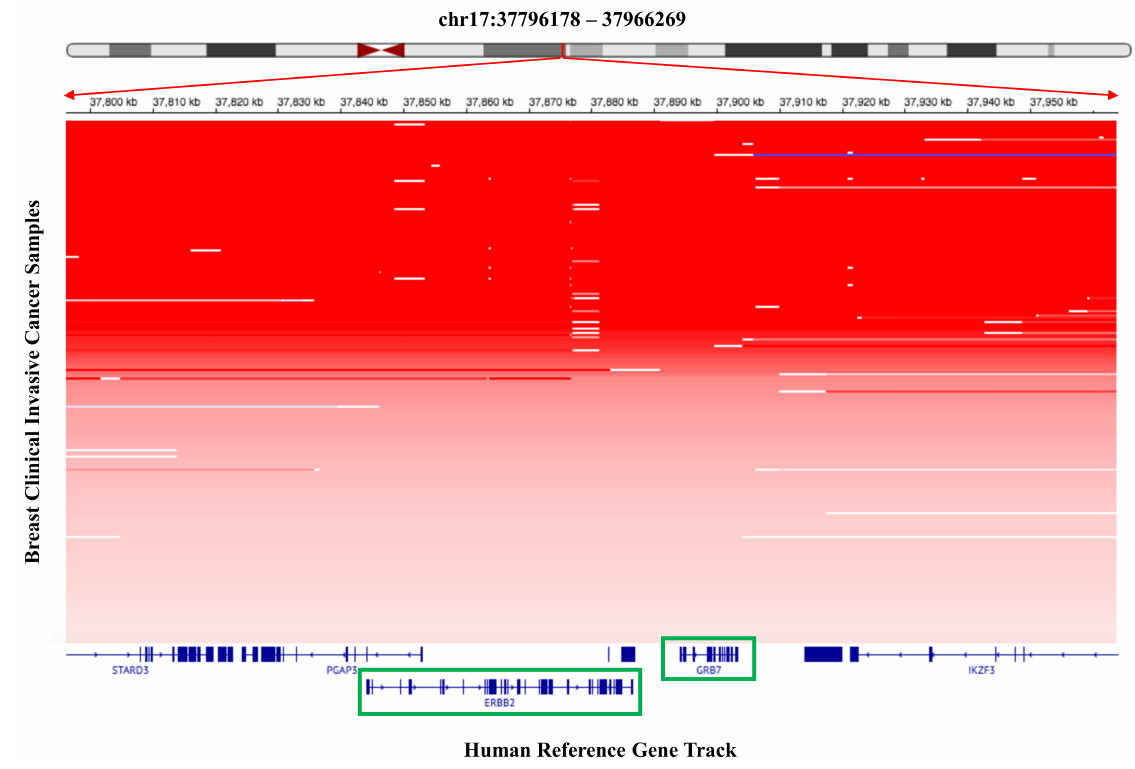
Figure 4. Co-amplification of GRB7 within ERBB2 genomic amplicon. The top panel shows ERBB2 genomic amplicon region (indicated by a red color line) in a human chromosome ideogram. The two red arrowheads indicate an expanded ERBB2 genomic amplicon region (chr17:37796178-37966269) harboring several co-amplified genes, which is scaled by a nucleotide position interval ruler for the human chromosome 17. The middle panel shows overall copy number amplifications of the ERBB2 genomic amplicon involving several genes within the regions surrounding the ERBB2 locus, including GRB7 , in TCGA breast clinical invasive carcinoma samples. The denser the red color is, the higher the degree of the copy number amplification in the genomic region is. The bottom panel shows genomic exon-intron structures of those genes residing within the ERBB2